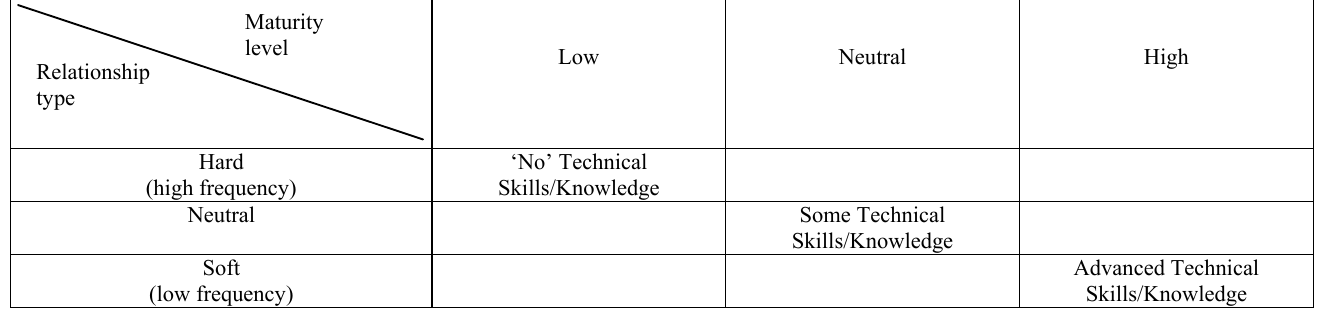
Figure 2: Maturity matrix for end user involvement